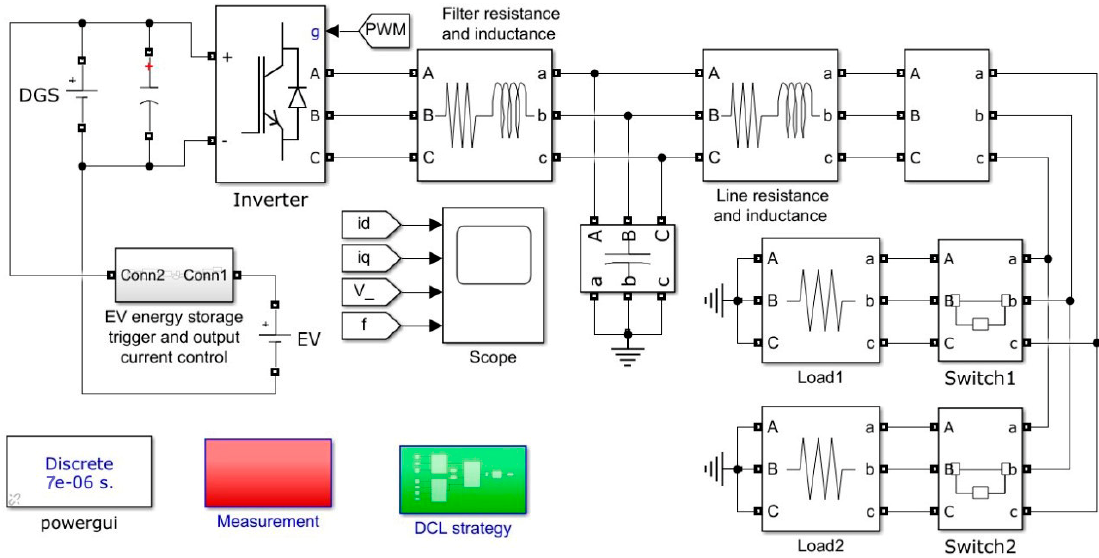
Figure 5. Simulation setup for the proposed errorless-control-targeted technique based on the ro- bust